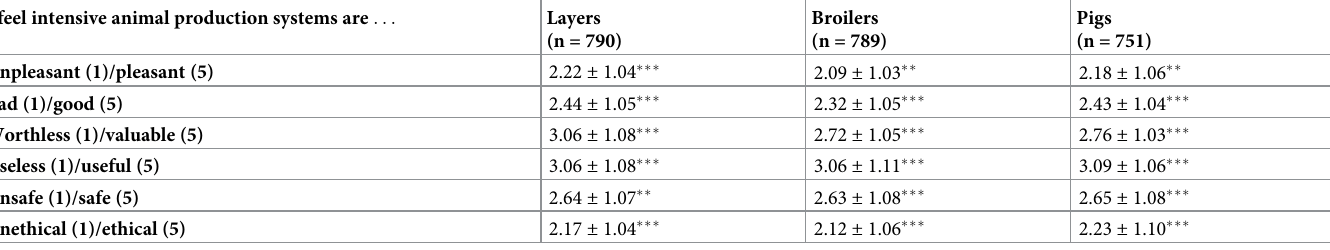
Table 1. Attitudes citizens towards intensive animal production systems for laying hens, broilers and pigs from 5 EU countries (mean rank on a linear scale: 1 to 5 ± SD). I feel intensive animal production systems are